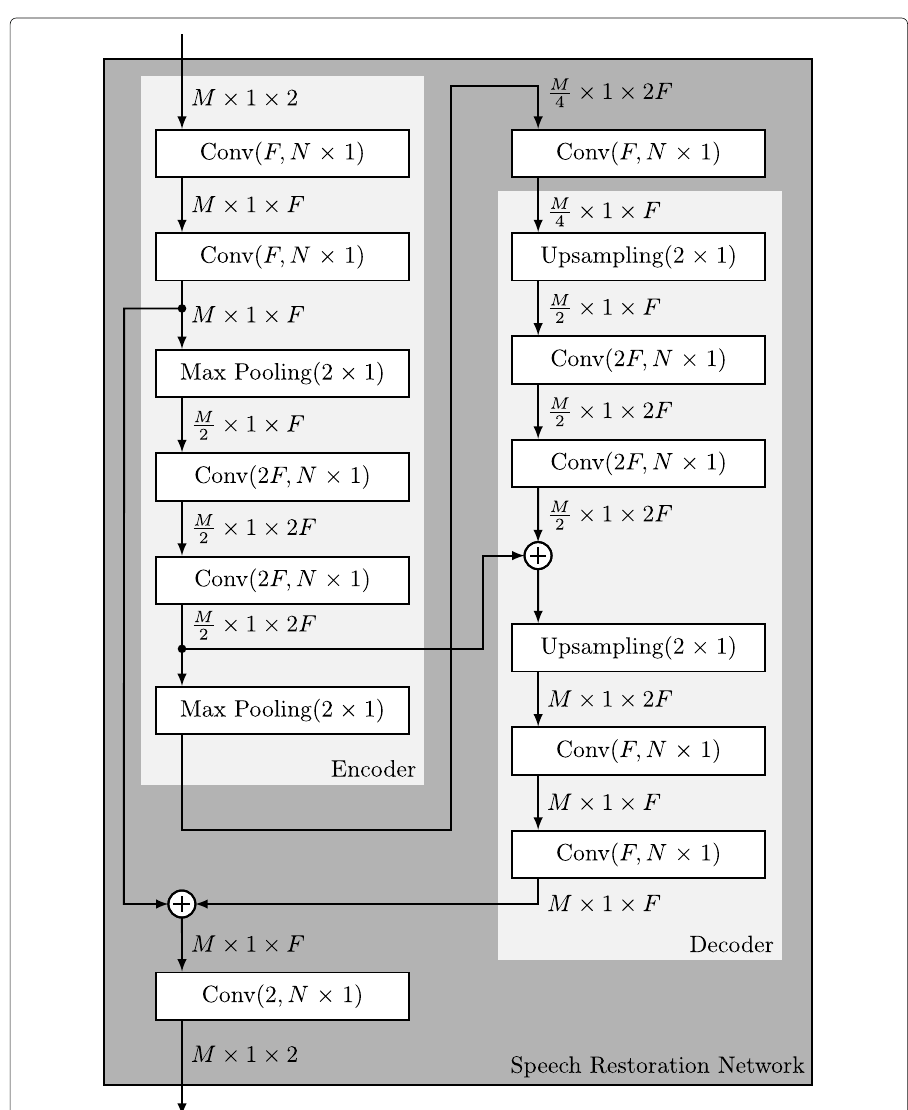
Fig. 3 Block diagram of the speechrestorationnetwork utilizing a CED network including encoder and decoder sub-networks with maximum pooling and upsampling layers ( du-setup ). The sizes of the feature representations inside the network regarding the frequency, frame, and feature map axis, respectively, are shown at the input and output of each layer